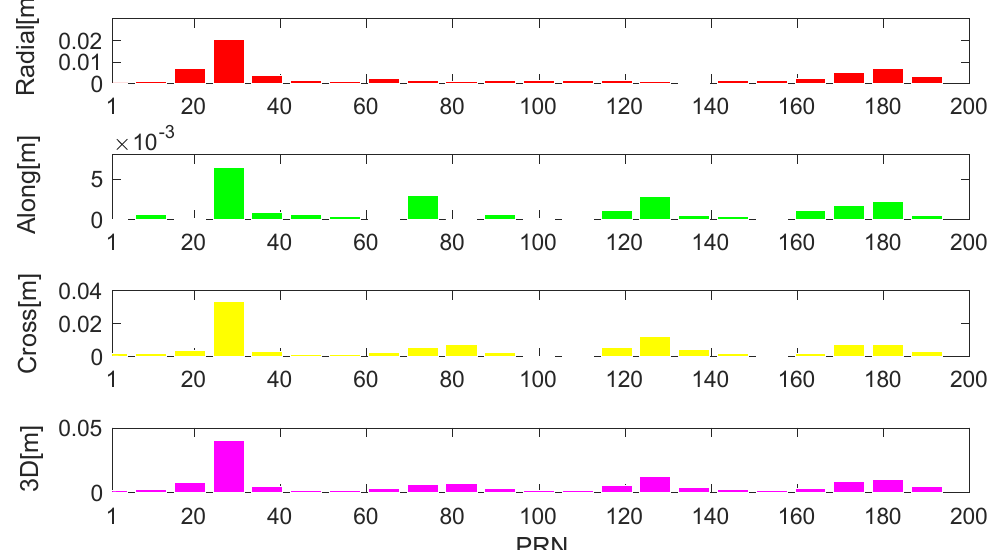
Figure 8. 120-LEO constellation orbital errors in radial, along-track, cross-track and 3D under 20 cm ranging accuracy, in which satellite of PRN 1,7,13…115 (divided at interval 6 of PRN number) are displayed.